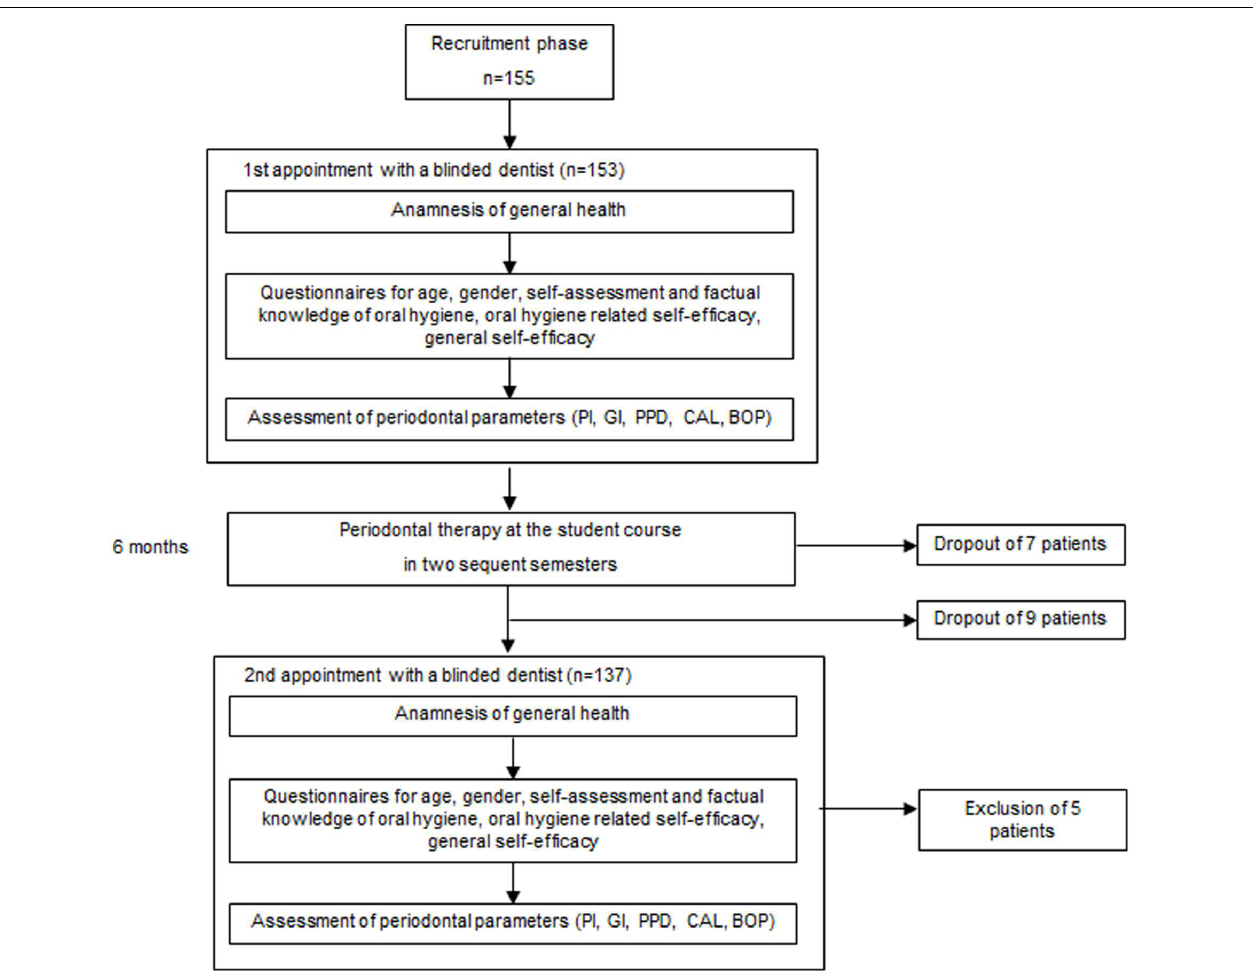
FIGURE 1 | Flow diagram of